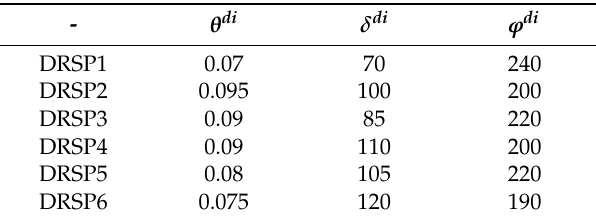
Figure 1. Forecasted price curve for 24 h. Table 5. Load curve data for DRSP’s.